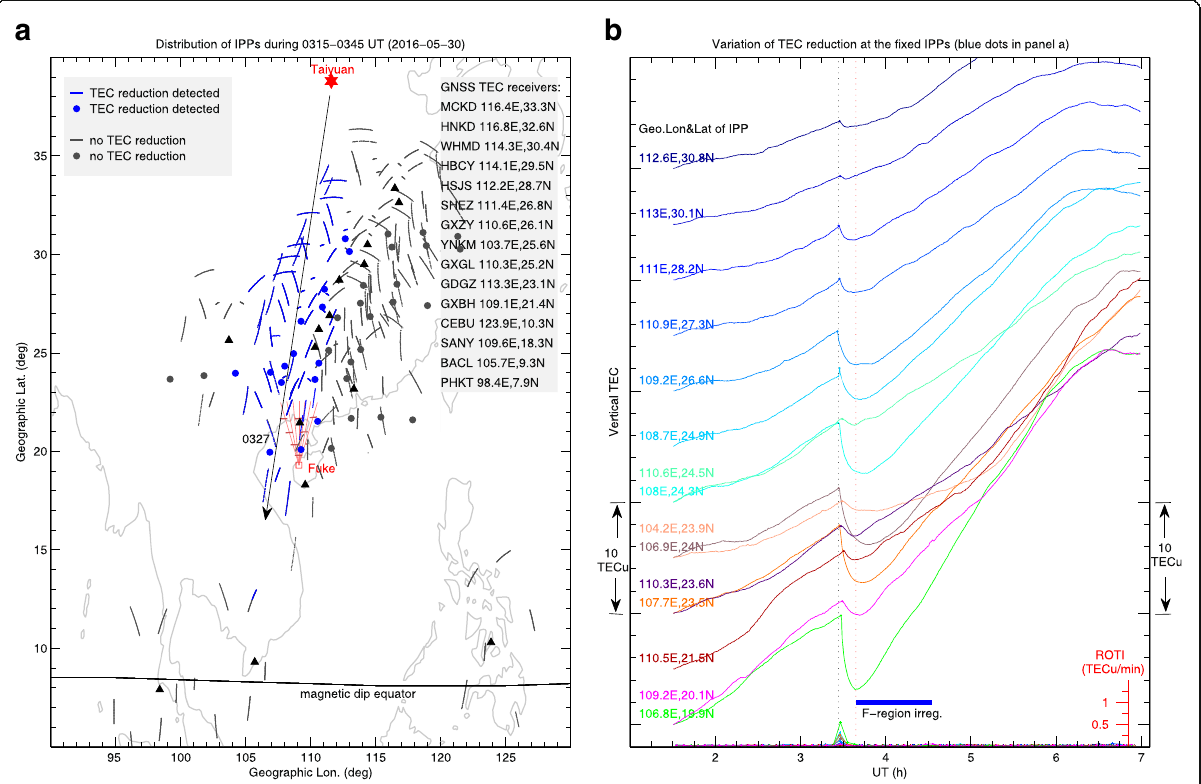
Fig. 3 a The geographic distributions of ionospheric pierce points (IPP) for the GNSS satellite-receiver links where the curves and dots marked by blue (gray) represent TEC reduction was (not) observed. The fan-shaped sector scanned by the seven beams of the Fuke radar is marked with red lines. The approximate trajectory of the rocket launched around 03:17 UT from Taiyuan is superposed in the plot. The triangles mark the locations of GNSS receivers, with the corresponding short name, longitude, and latitude listed in the right top. b Temporal variations of TEC reductions measured at the fixed IPPs from higher to lower latitudes (marked by blue dots in panel a ). The horizontal bar in the bottom represents the occurrence of daytime F-region